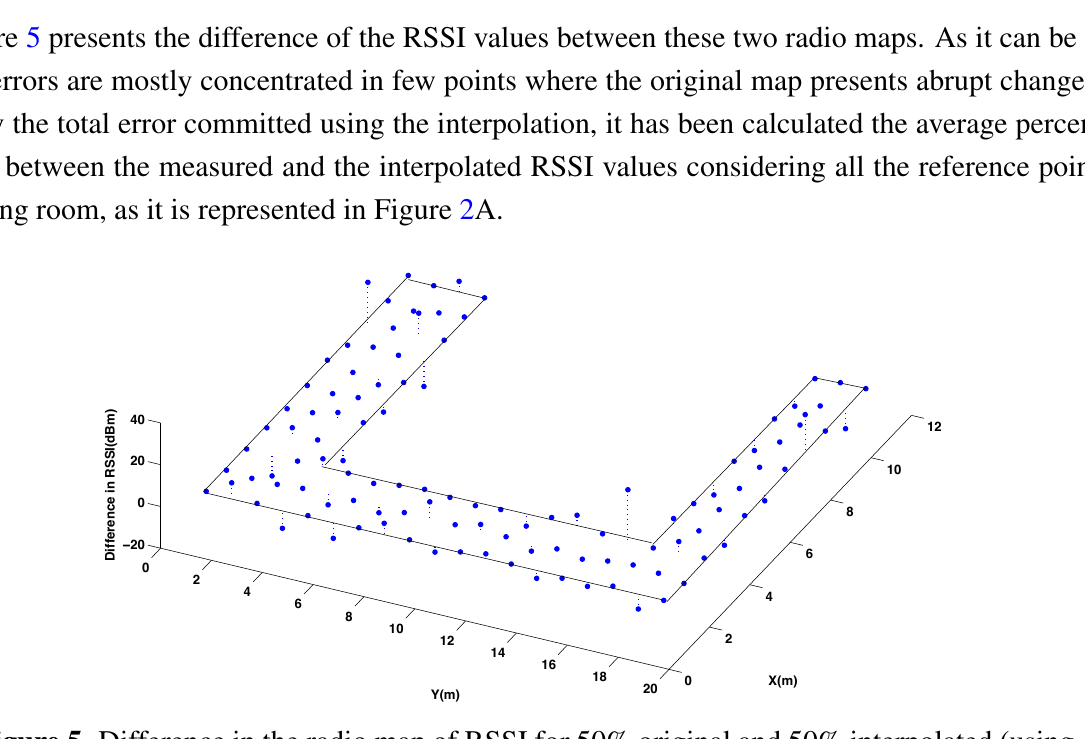
Figure 5. Difference in the radio map of RSSI for 50% original and 50% interpolated (using the thin spline function) reference points in the testing area. Using channel CH11 and power level P3.